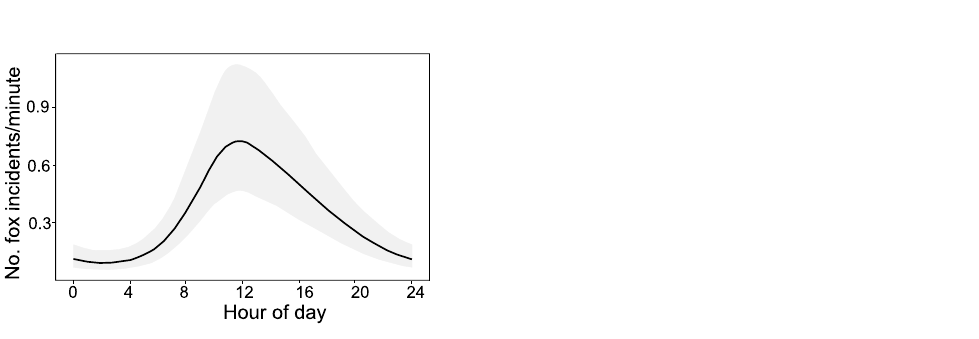
Figure 5. Probability of the red fox incident ( a ) during a year and ( b ) in the whole research period with comparison between weekdays and weekends as based on the reports on fox incidents in the city area (1998– 2015), delivered by the Municipal Forests—Warsaw.